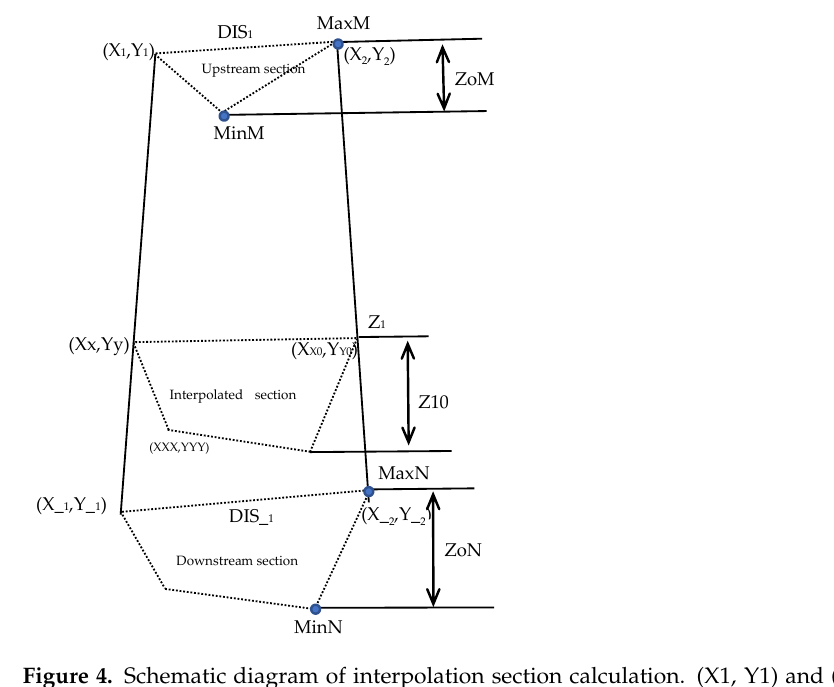
Figure 4. Schematic diagram of interpolation section calculation. (X1, Y1) and (X_1,Y_1) are the coordinates of the left bank nodes; (X2, Y2) and (X_2, Y_2) are the coordinates of the right bank nodes; (XX, YY) and (XX0, YY0) are the point coordinates on the left and right bank of the interpolation section; MinM is the lowest point of upstream section; MaxM is the highest point of upstream section; MinN is the lowest point of downstream section; MaxN is the highest point of downstream section; DIS 1 and DIS_ 1 are the width of upstream and downstream Sections. ZoM and ZoN are the maximal elevation difference of upstream and downstream section nodes, respectively; Z10 is the maximal elevation difference of interpolation section nodes. Z1 is the highest point of interpolation section.